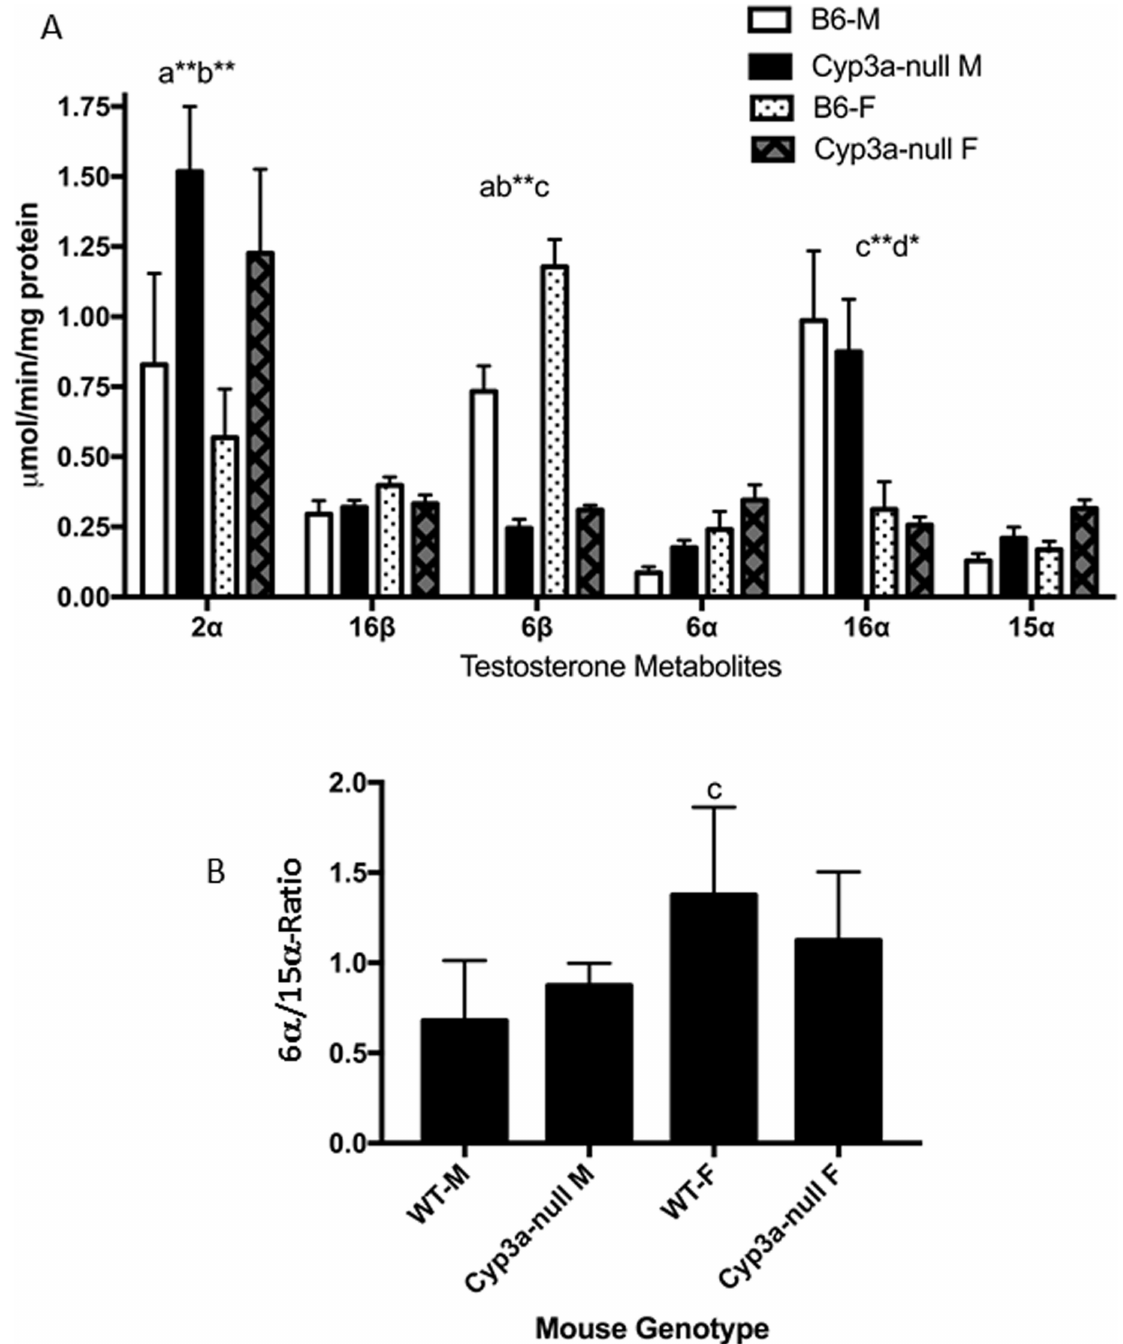
Fig 5. Changes in testosterone hydroxylation in Cy3a-null mice. (A) Testosterone hydroxylation was determined in male and female WT and Cyp3a-null mice as describedin the Materials and Methods. Data are presentedas mean specific activity ( μ mol/min/mg protein) ± SEM (n = 4). (B) Ratio of 6 α /15 α -hydroxytestosterone as a biomarker of CYP sexual dimorphism in the liver. An a indicatesa significantdifference betweenWT male and Cyp2b9/10/13-nullmale mice, b indicates a significant difference betweenWT female and Cyp2b9/10/13-nullfemale mice, c indicatesa significantdifference between male and female WT mice and d indicatesa significantdifference betweenthe male and female Cyp2b9/10/13-null mice. Statistical differences were determined by two-way ANOVA followedby Fisher’s LSD as the post-hoc test in (A) and one-wayANOVA followedby Fisher’s LSD in (B). A letter without an asterisk indicatesa significanceof p < 0.05, asterisk indicate significanceof * p < 0.01, ** p < 0.001, and *** p <